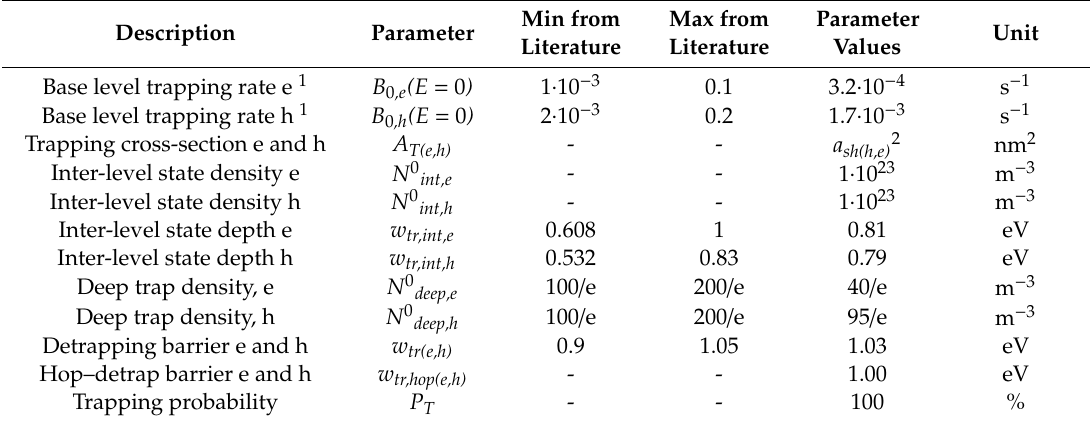
Table 4. Ranges of trapping and detrapping parameters from [3–11] and values used in the model.